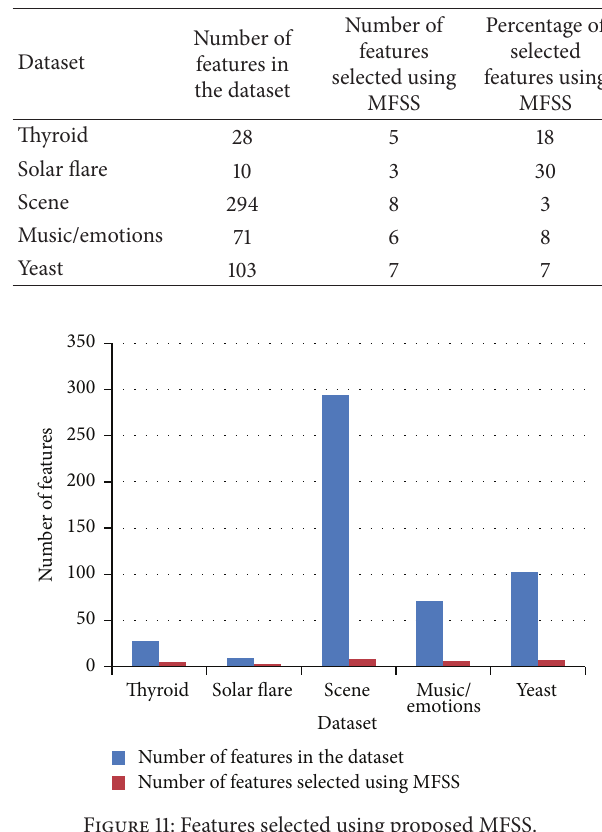
Table 9: Features selected using proposed MFSS.